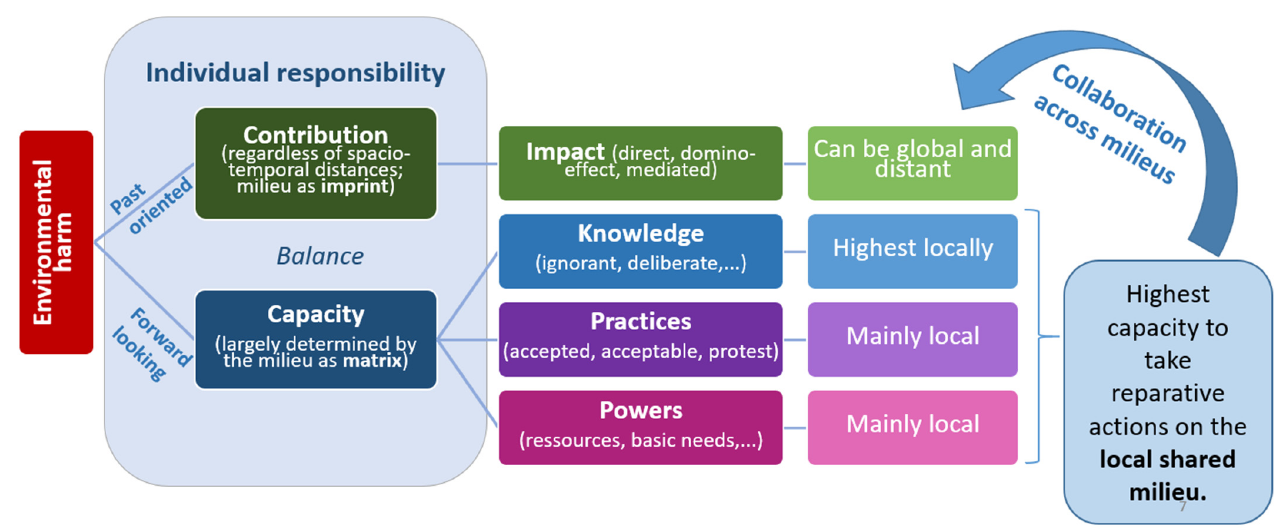
Figure 2. Responsibility for environmental harm and reparative actions. Source: Droz, L. The Concept of Milieu in Environmental Ethics: Individual Responsibility Within an Interconnected World . Routledge: Oxon, United Kingdom, 2021, p. 158. Sketches the account of individual responsibility for environmental harm. Individual responsibility results from the balance between past-oriented contributory responsibility and forward-looking capacity responsibility. The individual contribution to environmental harm amounts to the impacts of the individual ways of life, including omissions and domino-effect consequences. These harmful impacts can be global and distant. Yet, the capacity of an agent largely depends on her knowledge, available practices and her powers, which are all mainly rooted in the local milieu. As a result, the individual has the highest capacity to take reparative actions on the local shared milieu. To face the global consequences of distant impacts, collaboration across milieus is necessary.